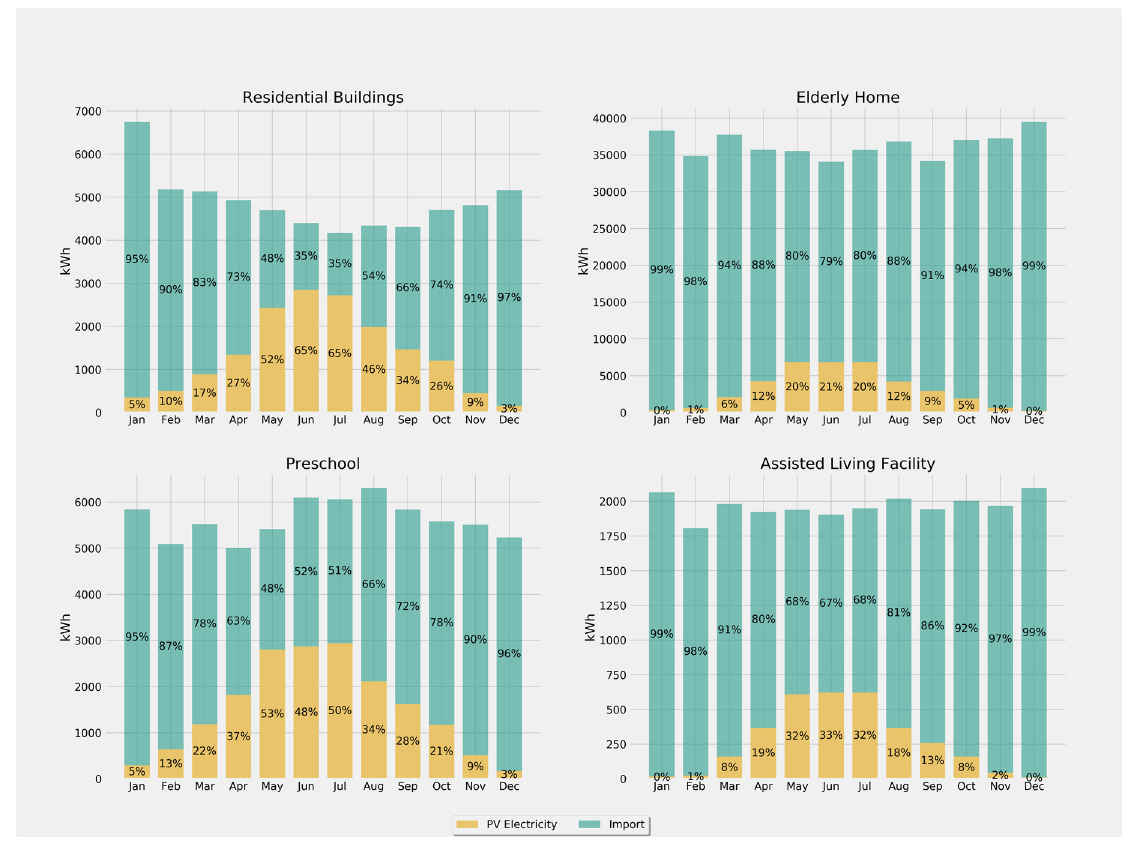
Figure 4. Monthly breakdown of energy produced from photovoltaic (PV) system into self-consumed energy (green) and energy exported to the synchronous grid